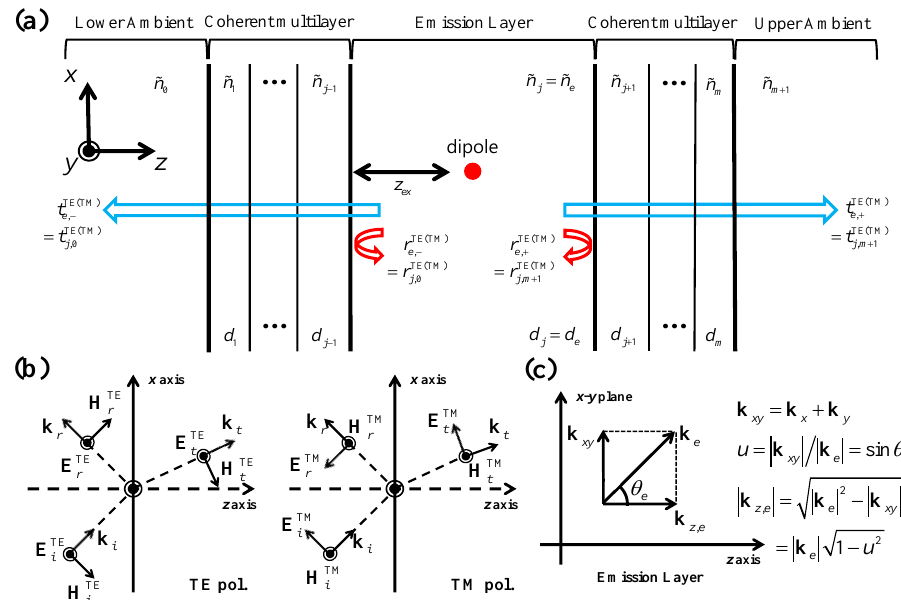
Figure 1. ( a ) Schematic diagram of the organic light-emitting diode (OLED) multilayer micro-cavity (MMC) structure. ( b ) Sign configuration of the transverse electric (TE)- and transverse magnetic (TM)- polarized electric and magnetic field amplitudes on reflection and transmission based on the Verdet convention. ( c ) Schematic diagram of the wave vector components in the emission layer (EML).